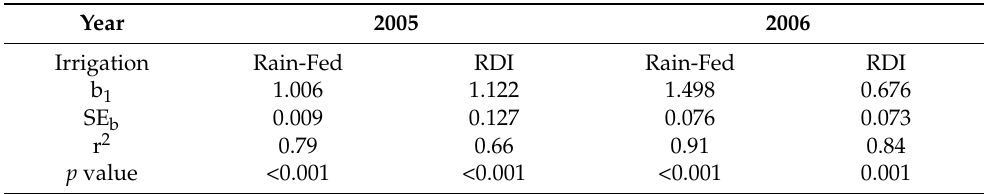
Table 3. Parameters from linear regression analysis (b 1 , SE b , r 2 , p values) between PDWP and SWP for years (Y) and irrigation treatments (I). Data of the two soils were pooled together.